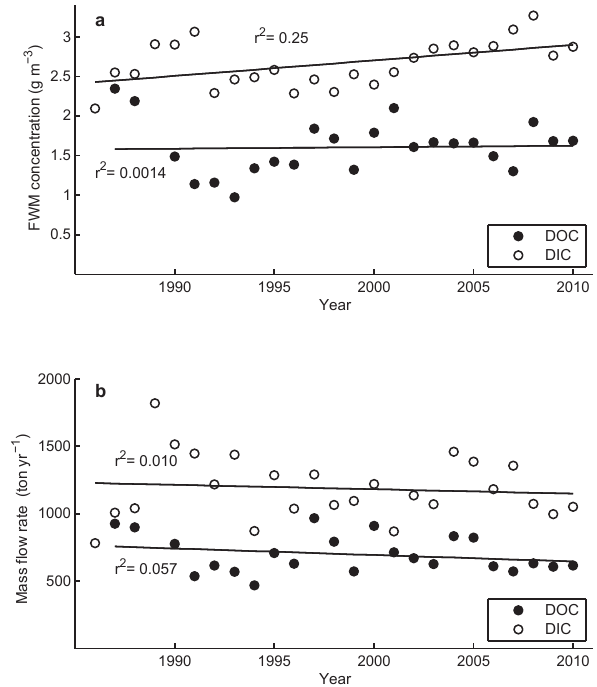
Fig. 7. Dissolved carbon time series. (a) Annual flow-weighted mean (FWM) concentration of DOC and DIC at the outlet of Abiskojokken catchment. The DIC concentration exhibits a signifi- cant ( p = 0 . 060) positive trend. (b) Annual mass flow rate of DOC and DIC at the outlet of Abiskojokken catchment; the relation be- tween mass flow rate, S , and mass flux, s , is as shown in Fig.